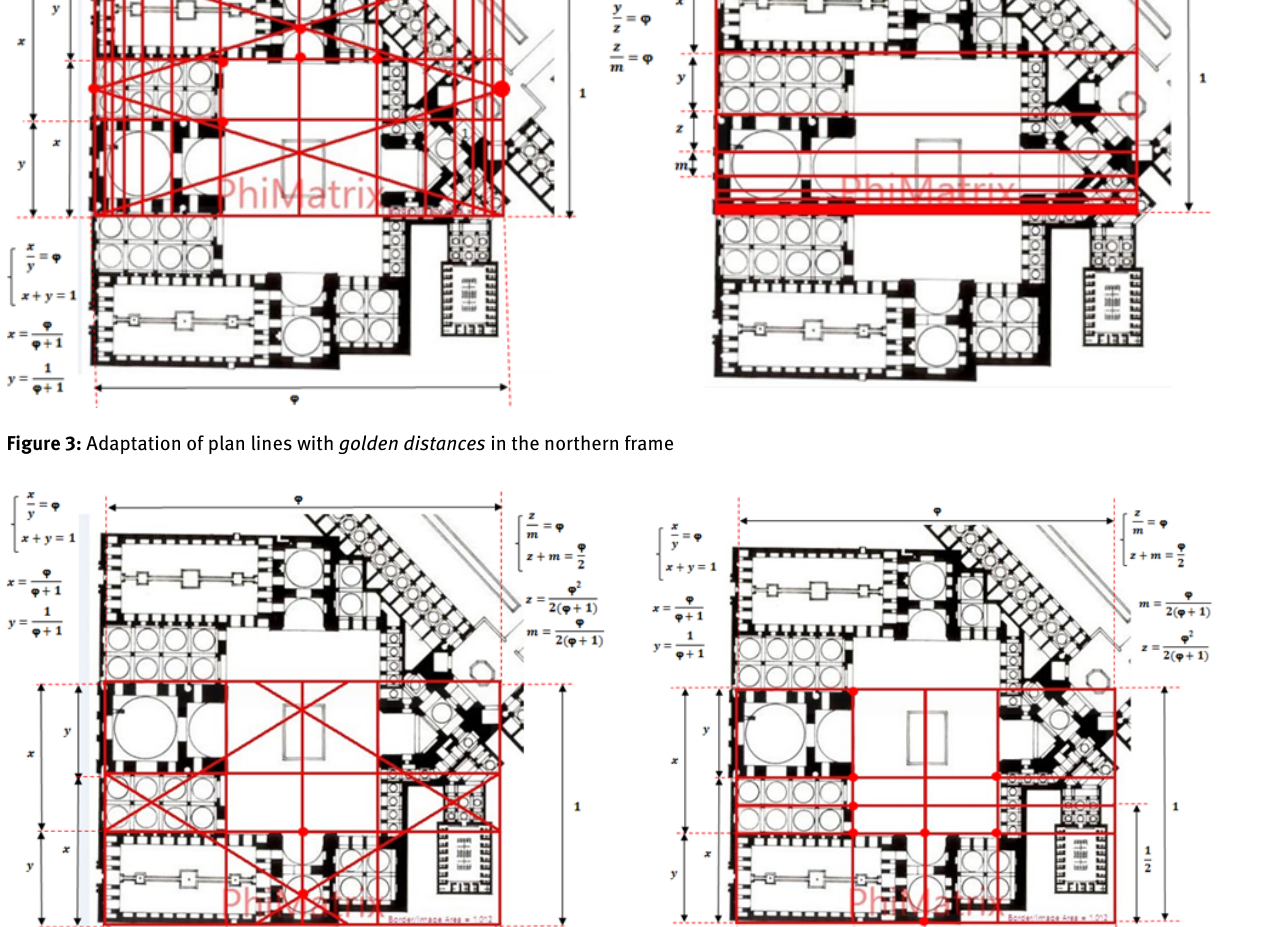
portion, also midpoint in left-hand side stay on the main entrance of the building (from Naghsh-e-Jahan